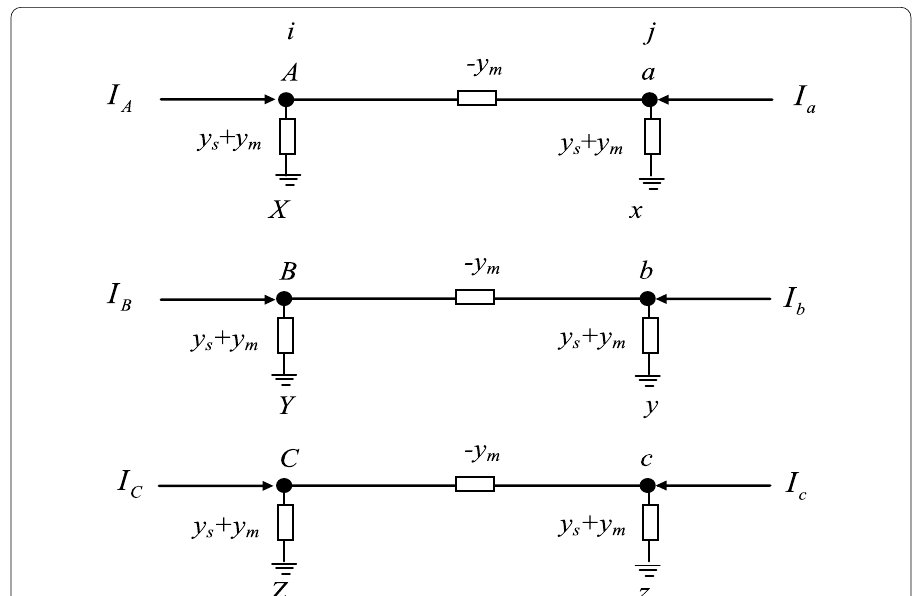
Fig. 8 Topology of the transformer by ignoring mutual-inductances; Ignoring mutual-inductances (When the magnetic circuits is balanced), Topology of the transformer is showed like this